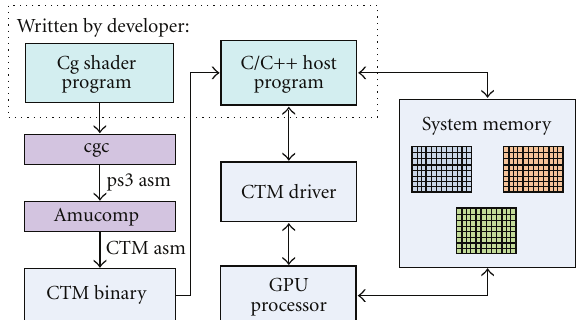
Figure 3: The software flow in our system. A software developer